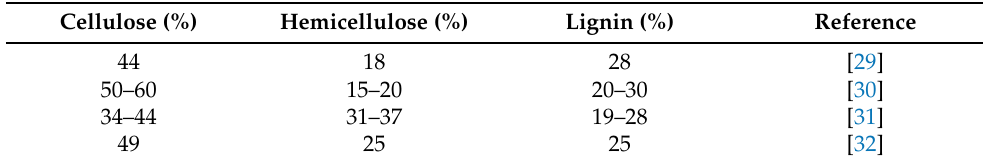
Table 1. Percentage of cellulose contained in hemp stalk.